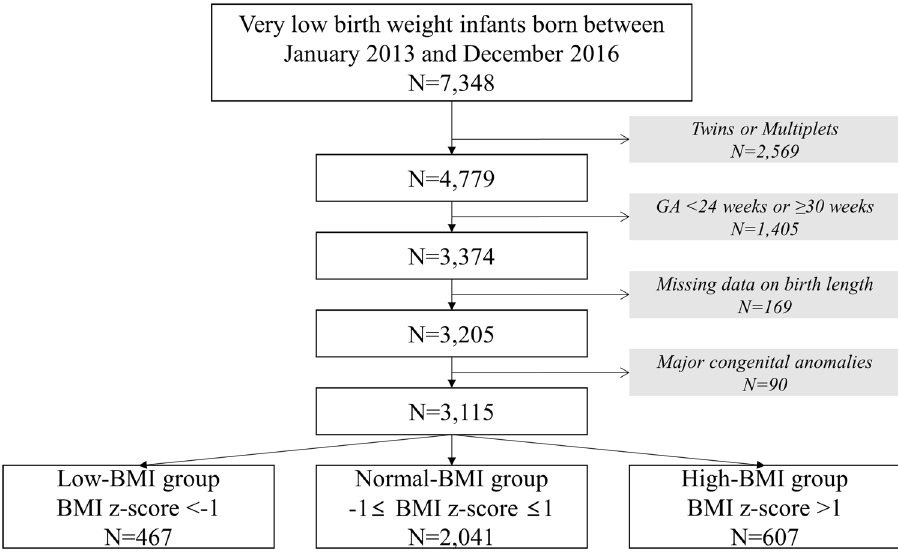
Figure 1. Flow diagram of the study population. GA gestational age; BMI body mass